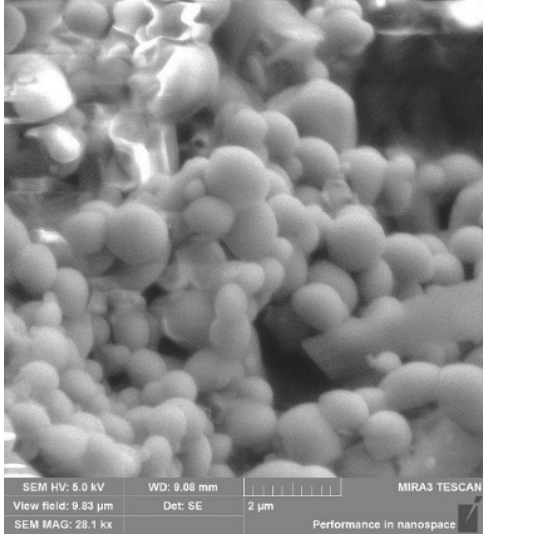
Figure 5. ( a ) Scanning electron microscopy (SEM) images of BSA-NPs (160 ± 5 nm) (scale = 2 µm, 5 kV). ( b ) SEM image of BSA-HU-NPs (180 ± 7 nm). Data are presented as mean ± SD ( n = 3).